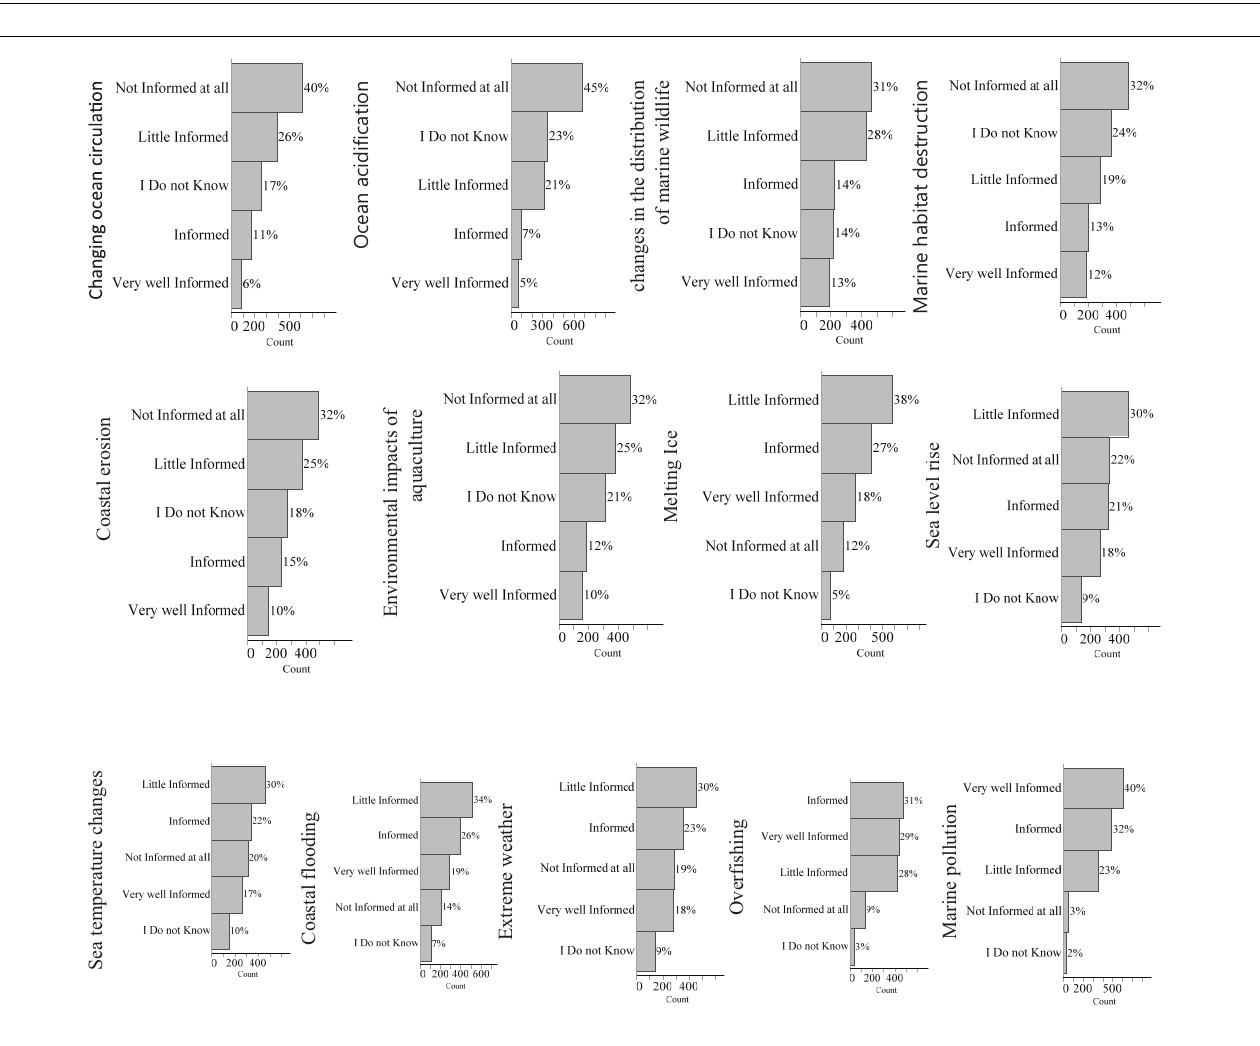
FIGURE 3 | Responses to the question: How informed do you feel about each of the following?